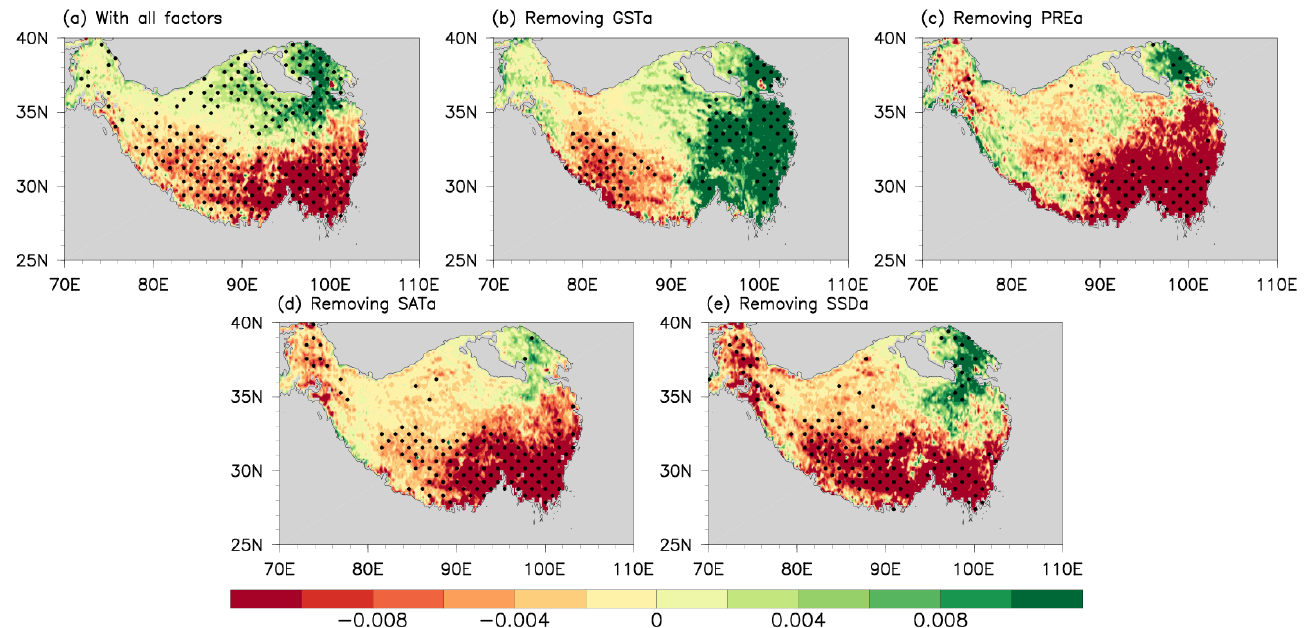
Figure 8. ( a ) JJAS NDVI anomalies regressed upon the combined-effect index for the DNI during the period 1982–2020. The other figures are as in ( a ), but for the regression upon the combined-effect index after removing the effect of the GST ( b ), PRE ( c ), SAT ( d ), and SSD ( e ) anomalies, respectively. NDVI anomalies significant at the 95% confidence level are stippled with black dots.